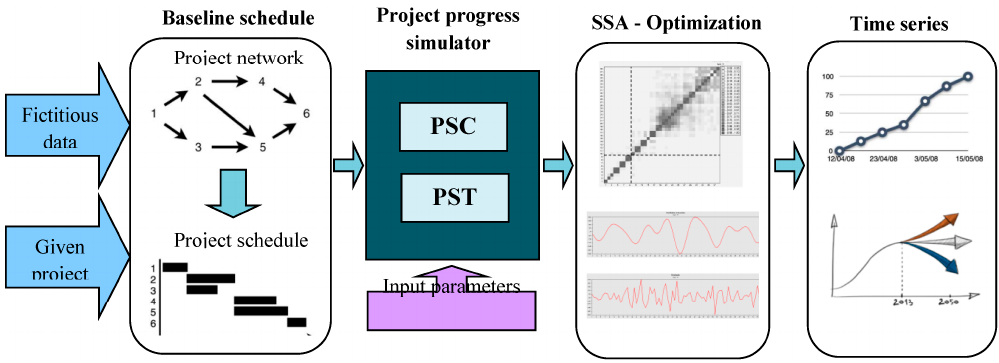
Figure 2. Project progress generator framework and its steps. PSC, Progress Simulation for Time; PST, Progress Simulation for Time.